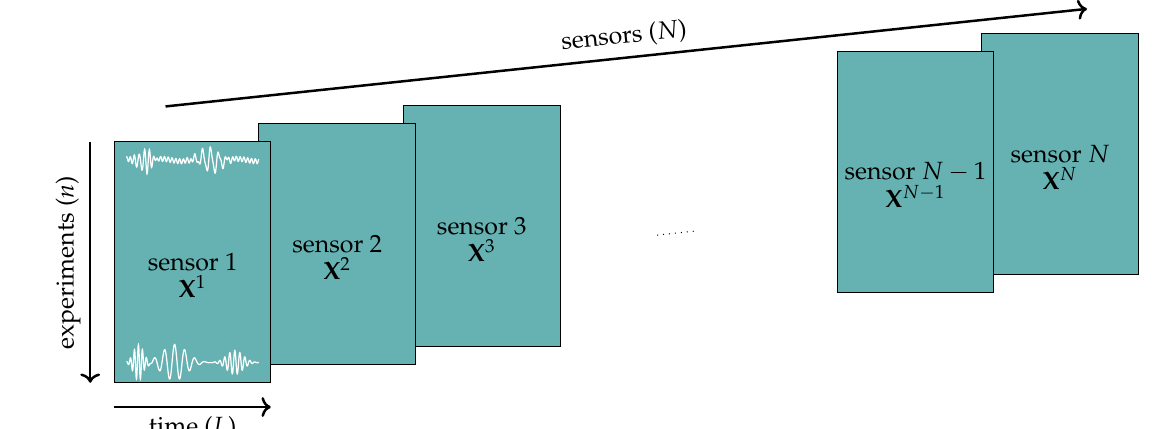
Figure 4. Initial arrangement of the collected data for mean centering unitary group